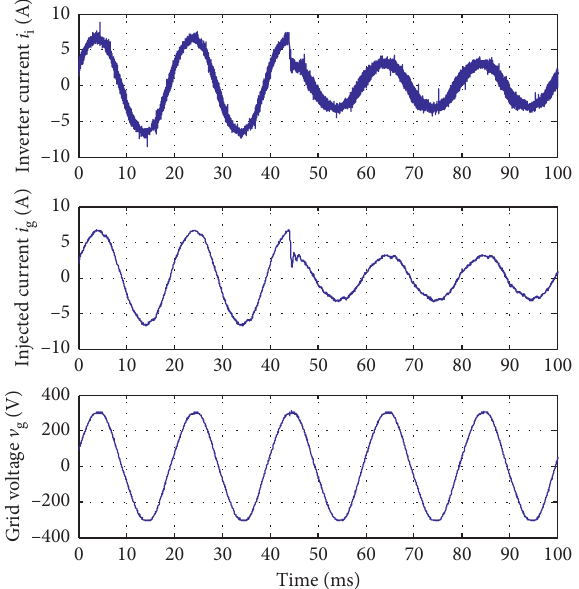
Figure 15: Experimental result when current reference drops to half load condition from full load